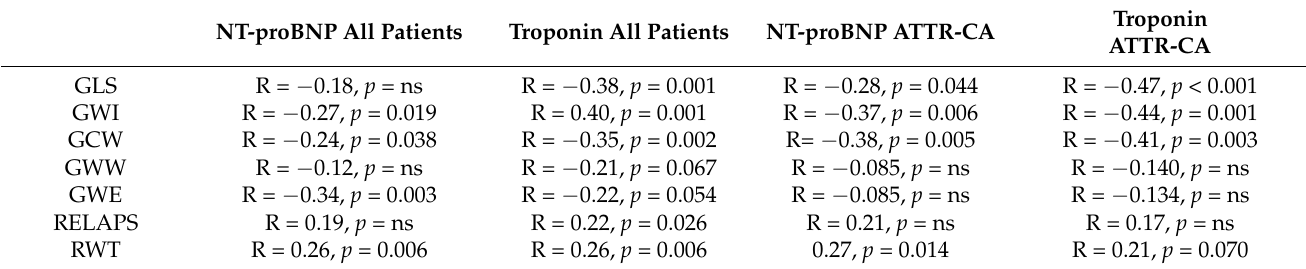
Table 4. Relation between myocardial work and biomarkers in all patients and in ATTR-CA. NT-proBNP All Patients Troponin All Patients NT-proBNP ATTR-CA